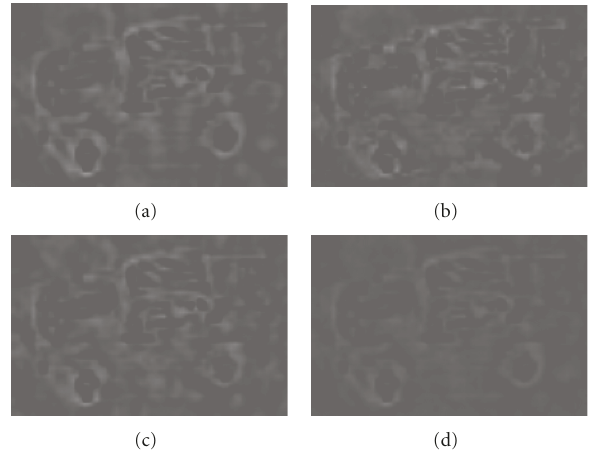
Figure 7: The di ff erence images between the original “Toys” image and restored “Toys” images in Figure 6: (a) by the curvelet Shrinkage method; (b) by using the “TV” model; (c) by using the “TVGF” model; (d) by using our proposed model.